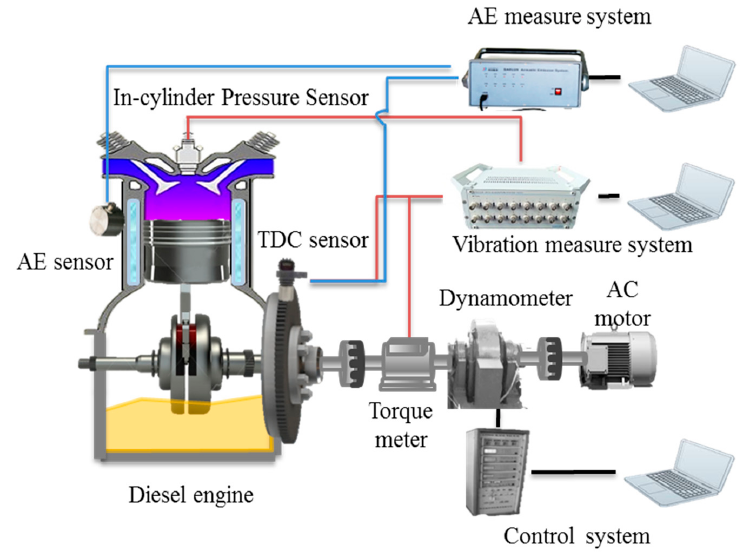
Figure 3. Schematic diagram of the diesel engine test system.